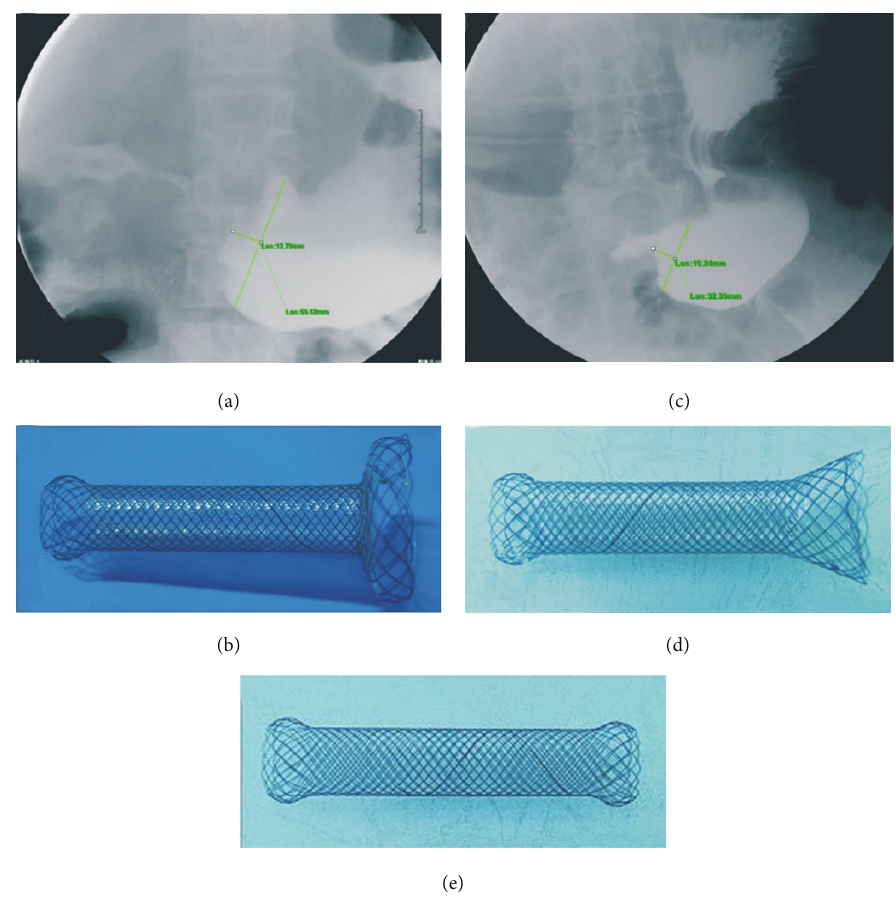
Figure 1: Examples of proximal GOO lumen shapes and images of GOO tailored stents for GOO. The distal portion of the GOO tailored stents was semispherical, with a length of 20 mm and a diameter of 28mm. The middle segment had a diameter of 20mm. The overall length of the stents was 100 mm. (a) A cup-shaped obstruction and (b) a cup stent. The proximal ends were large cup-shaped (53.3 mm ± 5.5 mm in diameter, 15 and 20 mm in length). (c) A funnel-shaped obstruction and (d) a funnel stent. The proximal ends were funnel-shaped (33.6 mm ± 3.6 mm in diameters, 25mm and 30 mm in lengths). (e) Standard uncovered stent. The length of the stents was 100mm and the ends were semispherical with diameters of 28 mm and length of 20 mm.